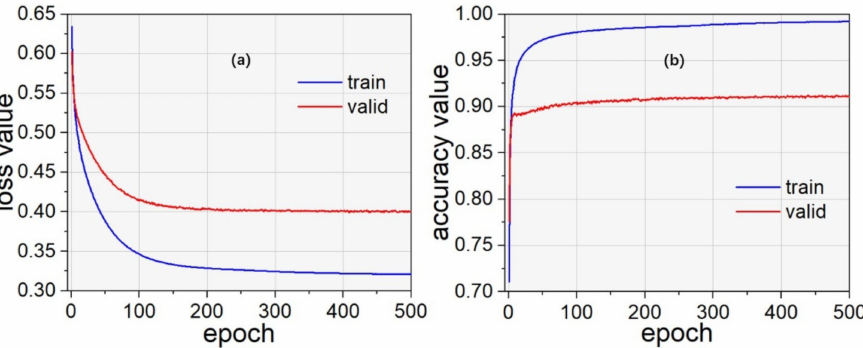
Figure 5. Loss and accuracy curves of ResNet101 on the xView2 dataset. ( a ) Loss value. ( b ) Accuracy value.